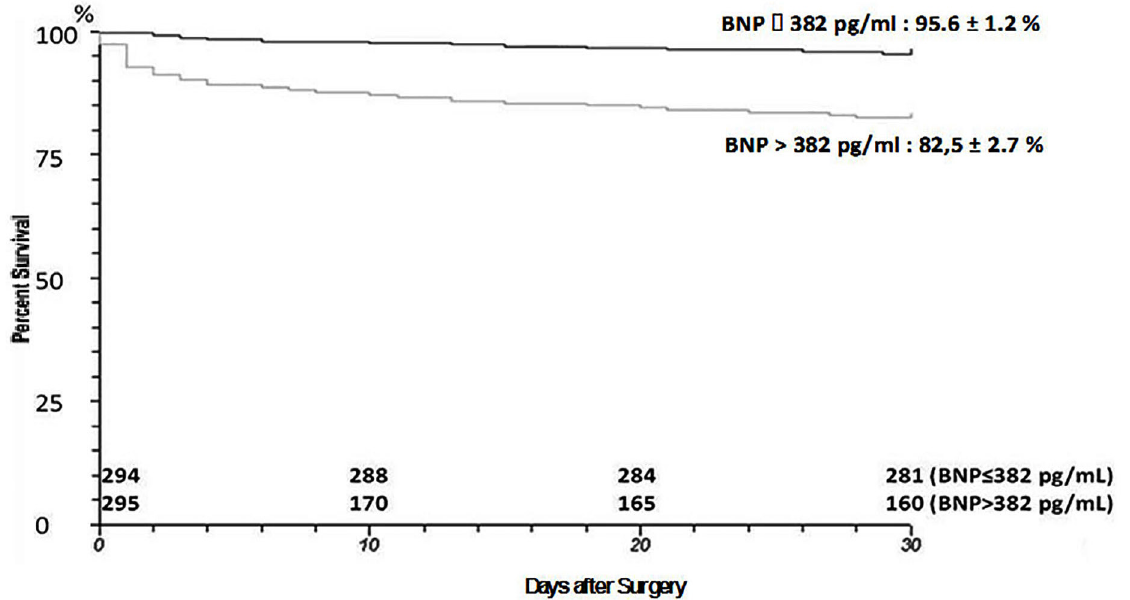
Fig. 2 - Kaplan-Meier’s curve for survival at 30 days postoperatively. BNP=brain natriuretc peptide